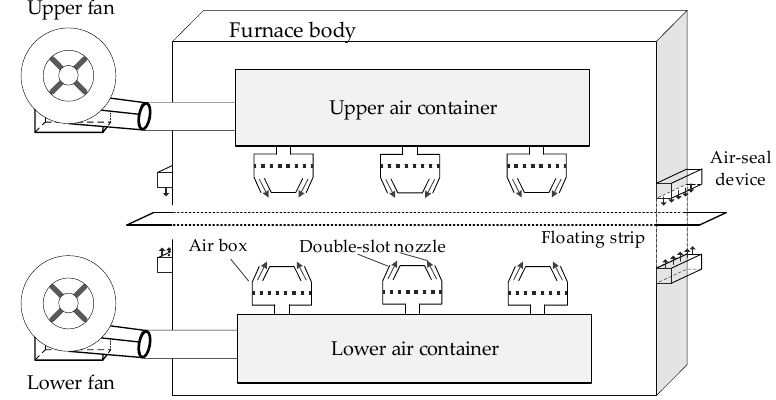
Figure 6. The schematic diagram of an air cushion furnace.